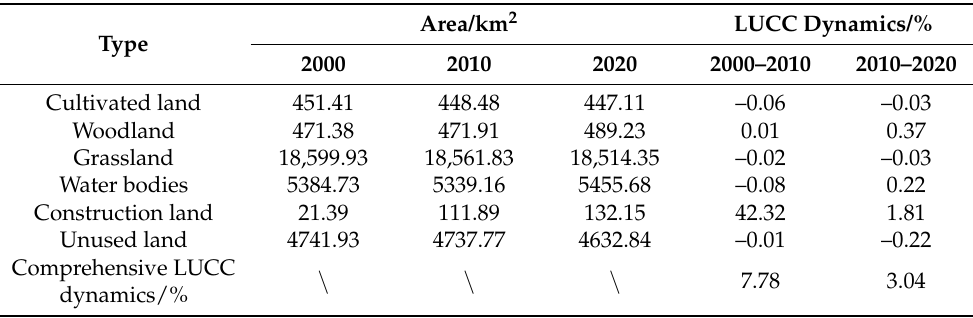
Table 1. Area and dynamic changes of land use/land cover (LULC) types in Qinghai Lake Basin